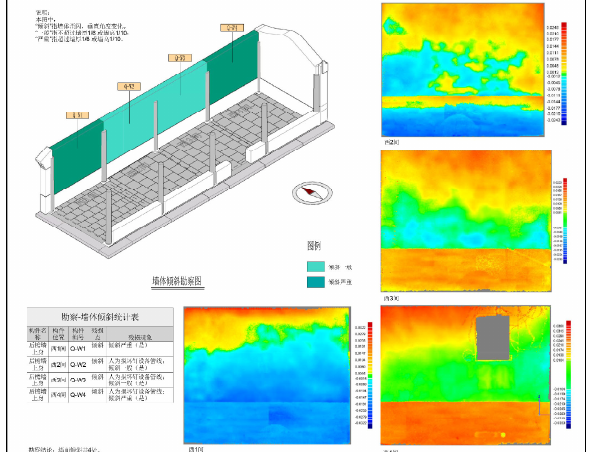
Figure 14 Online e-albums linked with the BIM model